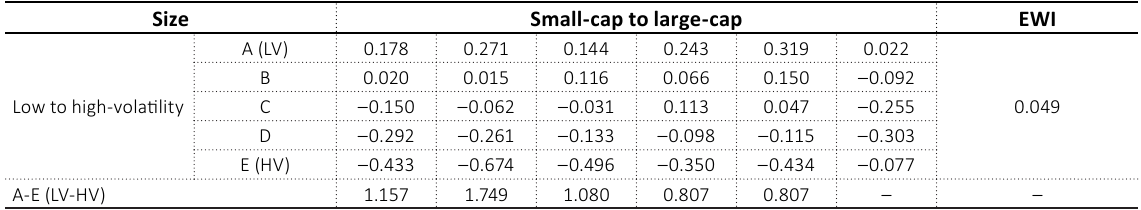
Table 6. Sharpe ratio of quintile portfolios independently sorted on size and volatility Size